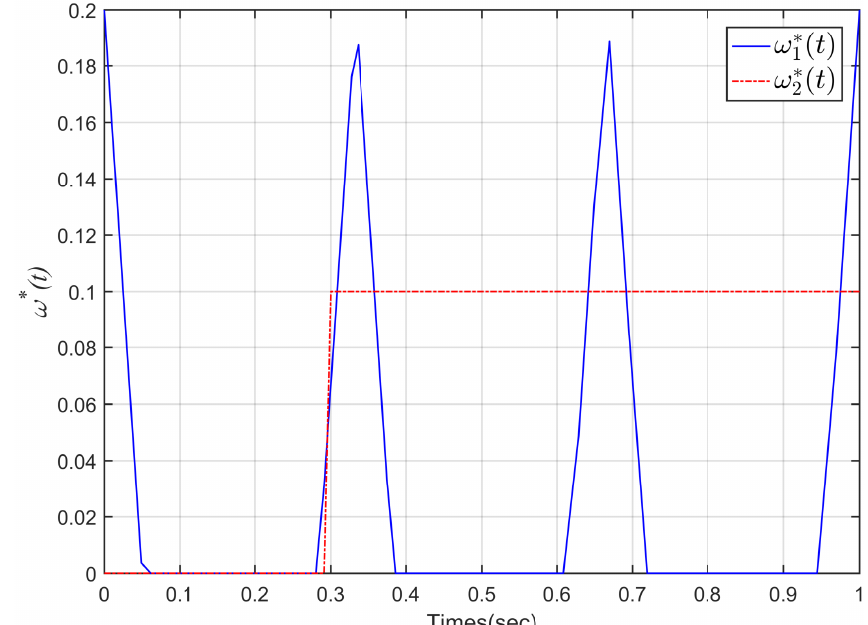
Figure 3. Two different disturbances ω ∗ ( t ) .